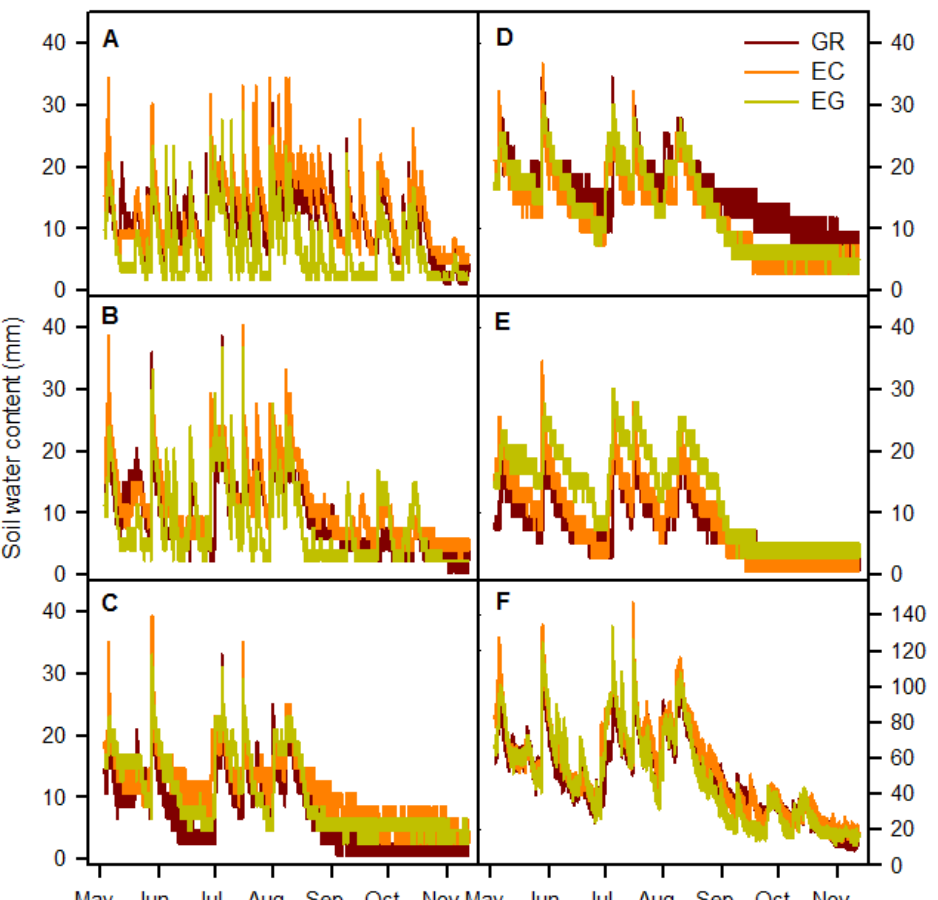
Figure 2. Volumetric soil water content (mm) in the soil profile from (A) 0–10 cm; (B) 10–20 cm; (C) 20–30 cm; (D) 30–50 cm; (E) 50–107 cm; (F) 0–107 cm for